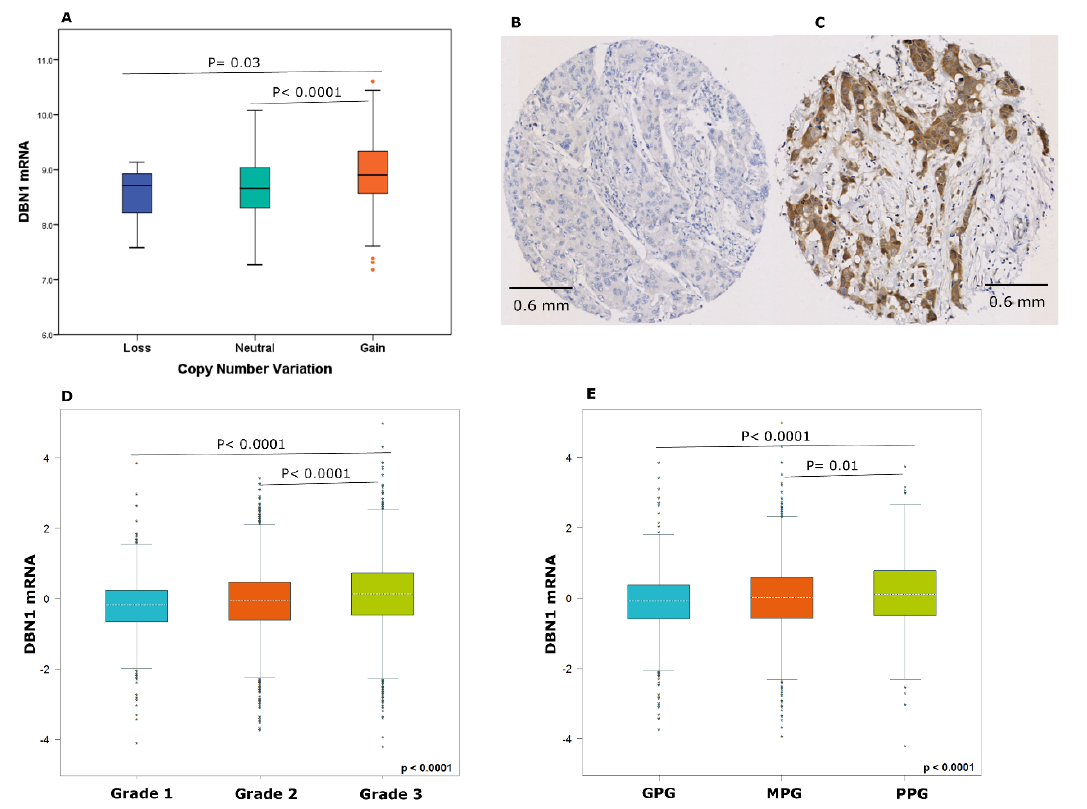
Figure 2. ( A ) DBN1 copy number variation and relationship with mRNA expression in the METABRIC cohort using one-way analysis of variance and the post-hoc Tukey test. Representative immunostaining images of invasive breast cancer using IHC ( B ) negative and ( C ) positive for DBN1 protein expression. DBN1 mRNA expression and its association with the clinicopathological parameters. ( D ) tumour grade and ( E ) the Nottingham Prognostic Index, using the bc-GenExMiner dataset.